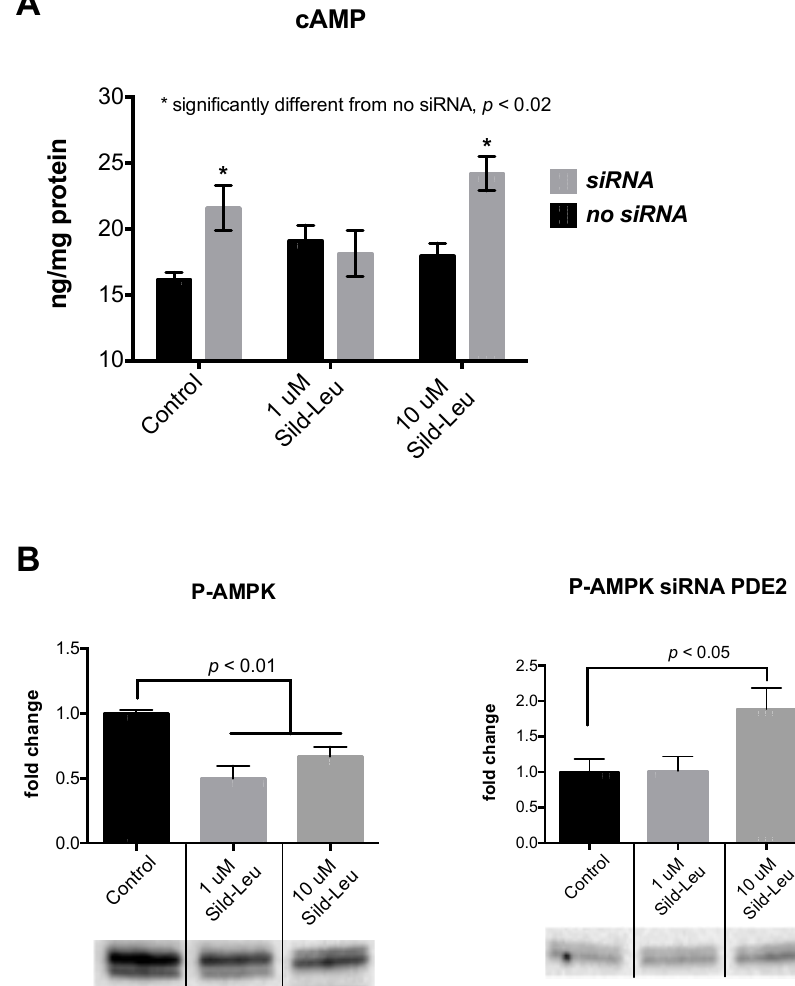
Figure 6. Change in cAMP and P-AMPK protein expression for treatment with PDE siRNA. HepG2 cells were treated with or without PDE2 siRNA for 48 hours, which was followed by 30-minute treatment with Sildenafil (1 or 10 µ M) – Leucine (0.5 mM). ( A ) Intracellular cAMP concentration was measured. * indicates a significant di ff erence between the cells treated with siRNA as opposed to the ones not treated with PDE2 siRNA ( p < 0.02). ( B ) Phospho (Thr172)-AMPK protein expression was measured. Bar graphs of densitometry measurements and representative blots are shown ( n = 3).